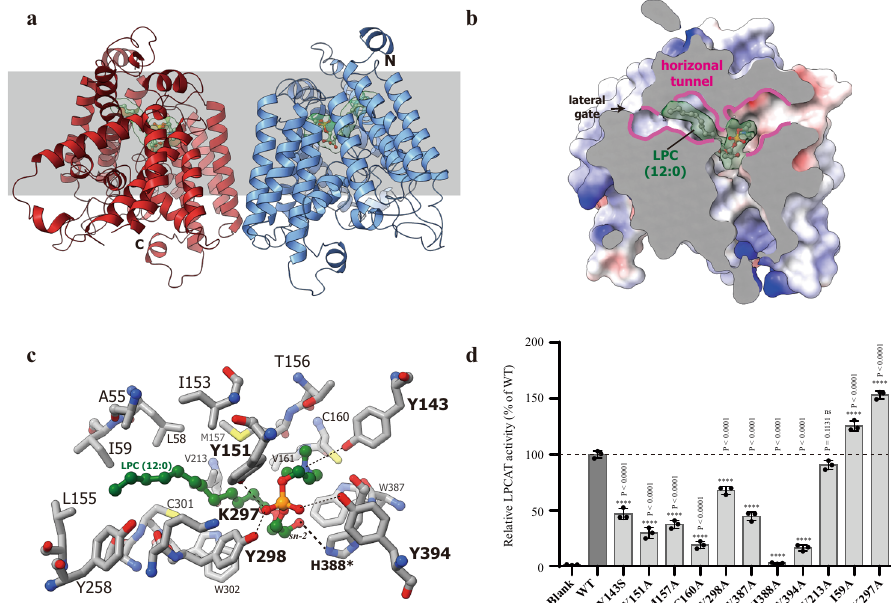
Fig. 3 The cryo-EM structure of cLPCAT3 bound with LPC (12:0). a The cartoon representation of the cLPCAT3/LPC molecular model as viewed parallel to the ER membrane. The non-protein electron density in the horizontal tunnel was shown in the green surface and the LPC (12:0) molecules that fi t in the density were shown as a stick-and-ball model. b The binding of the LPC molecule within the horizontal tunnel. The intersecting surfaces of the T-shape chamber of cLPCAT3 were shown parallel to the ER membrane. The horizontal tunnel was highlighted in pink. c The interaction of LPC with residues in the horizontal tunnel. The catalytic residue H388 was marked with an asterisk. d The TLC assay results on the puri fi ed wild type cLPCAT3 (dark column) and LPP-related mutants (gray columns). The enzymatic activities of mutants were normalized as the percentage of that of the wild type cLPCAT3. The results were shown as mean ± s.d. of experiments, n = 3 independent experiments for all mutants. One-way ANOVA with Dunnett ’ s multiple comparisons test was applied and the 95% CI was calculated by Graphpad Prism (version 6.01) and p -values were labeled above the